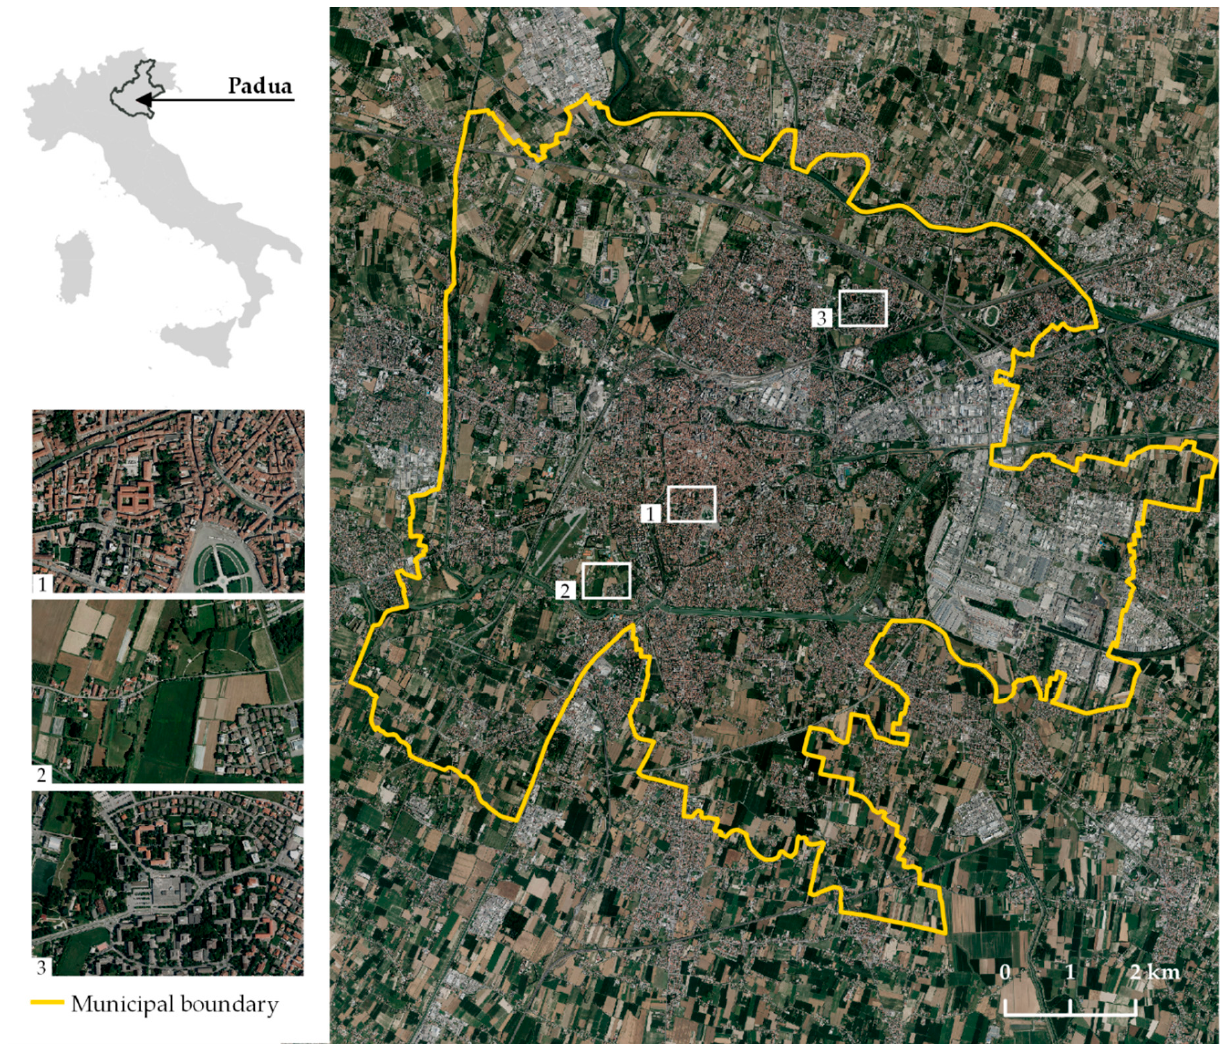
Figure 1. Geographical framework of Padua (Italy) and a zoomed-in image on different types of urban fabric of the city.